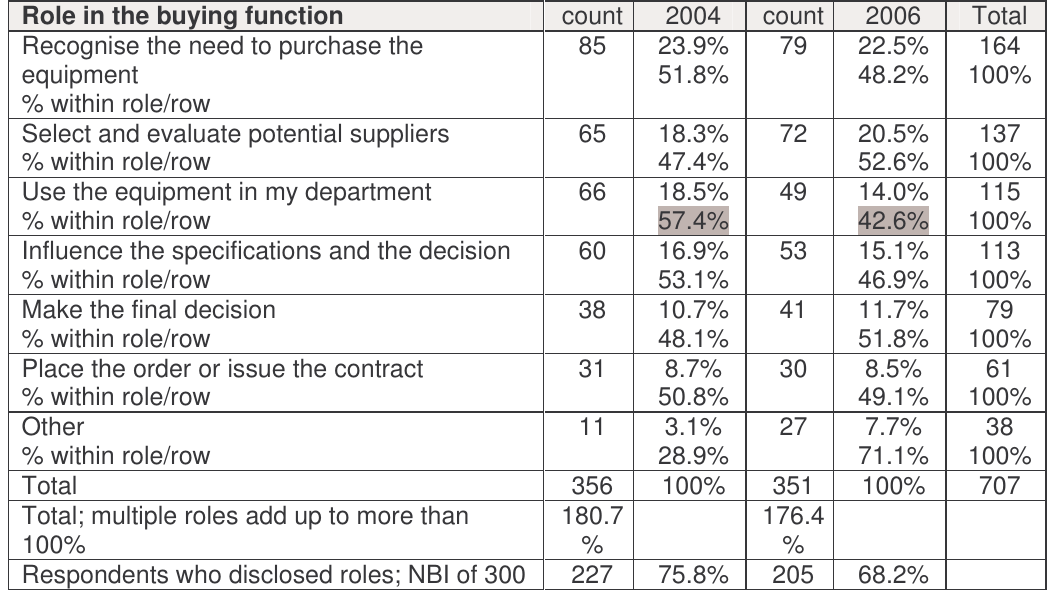
Table 6: Net buying influences; role of attendees at a trade show in the buying function Role in the buying